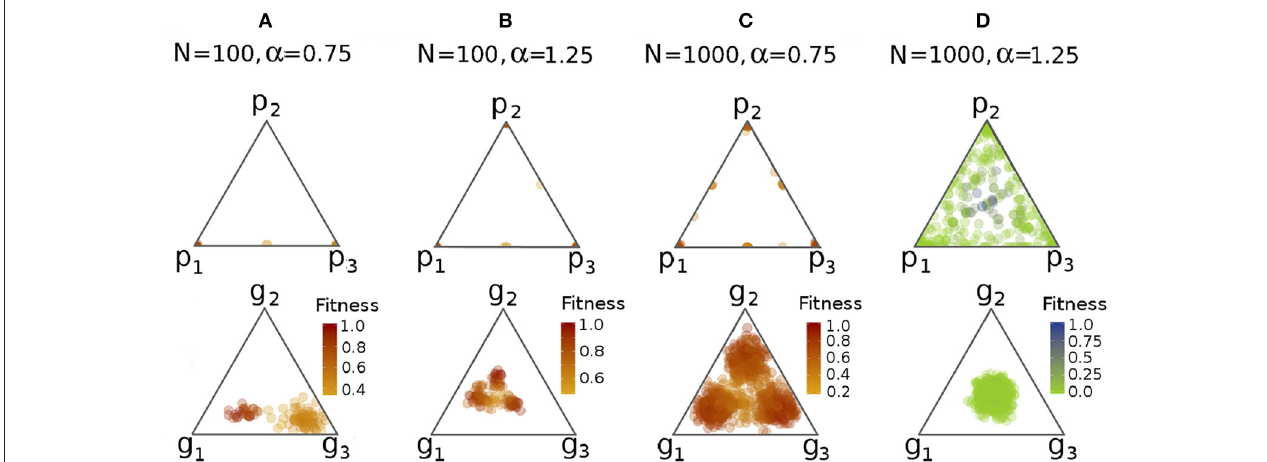
FIGURE 4 | Phenotypic and genetic profiles in the T = 3 case with varying trade-off and group size. In the top row simplexes capture the probability distribution between the three tasks, in the bottom row the relative genetic value distribution between the three tasks. Each point corresponds to an individual, and plots contain all group members. Panels A and B represent smaller groups with stronger (A) and weaker (B) trade-offs, while panels C and D represent larger groups with stronger (C) and weaker (D) trade-offs. Panel D is the only one depicting the subsistence case. Reddish colors represent the producer, greenish the subsistence case. For further parameters, see Table 1 .